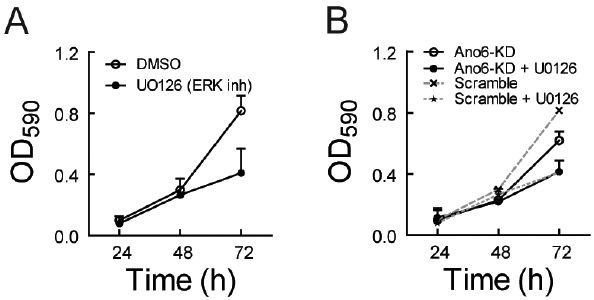
Figure 4. Effect of the ERK inhibitor UO126 on proliferation of control and Ano6 -KD C2C12 myoblasts. (A) Proliferation analysis of control C2C12 cells treated by UO126 (10 m M) or the vehicle alone (DMSO) measured by MTT assay. (B) Proliferation analysis of Ano6 -KD C2C12 cells treated by UO126 or the vehicle alone (DMSO) measured by MTT assay. Note that the dashed lines were re-plotted from panel